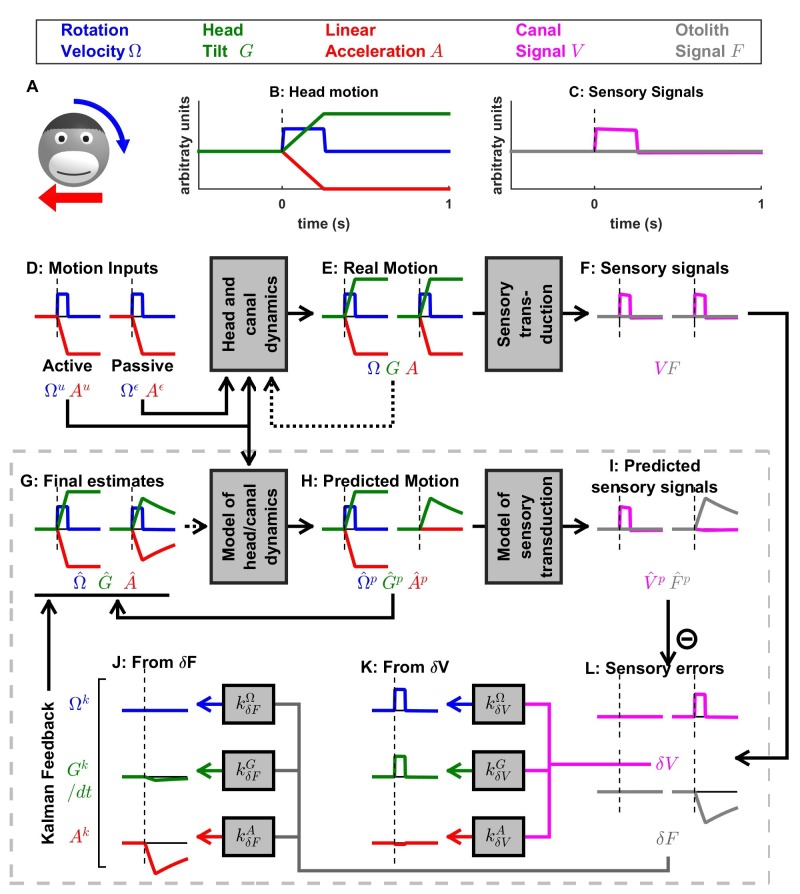
Simulation of simultaneous tilt and translation.Head tilt (as in Figure 5) and translation (as in Figure 6 but in the opposite direction) are performed simultaneously. As a consequence, the otolith signals (that are identical in Figure 5C and Figure 6C) now cancel each other (panel C, gray trace). This protocol can be seen as an activation of the semicircular canals that indicates a tilt movement, but in the absence of the corresponding tilt-induced activation of the otolith organs. As expected, and in agreement with behavioral (Angelaki et al., 1999; Merfeld et al., 1999) and neuronal findings (Angelaki et al., 2004; Shaikh et al., 2005; Yakusheva et al., 2007; 2008; 2013; Laurens et al., 2013a; Laurens et al., 2013b), the results of a tilt-translation simulation are the sum of a tilt simulation and a translation simulation (the latter being reversed). Interestingly, this simulation illustrates how activation of the semicircular canals without a corresponding activation of the otoliths leads to an otolith error (panel L, gray trace signaling δF). This simulates how translation-selective neurons in the vestibular nuclei and cerebellum modulate during tilt-translation in experimental studies using this stimulus (Angelaki et al., 2004; Shaikh et al., 2005; Yakusheva et al., 2007; 2008; 2013; Laurens et al., 2013a; Laurens et al., 2013b).